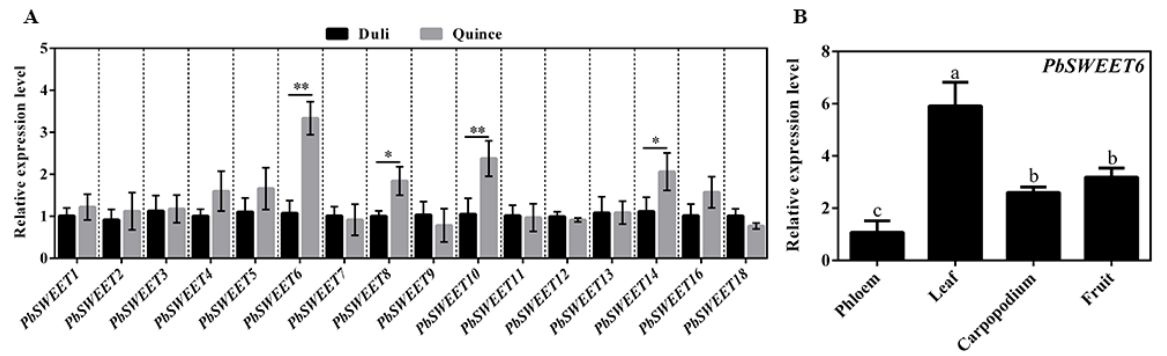
Figure 3. Selected and tissue-specific expression analysis of PbSWEET6 . ( A ) Relative expression of PbSWEET genes from mature fruits of ‘Zaosu’ pear grafted on ‘Yunnan’ quince (Z/Q) and ‘Duli’ (Z/D) as determined by qRT-PCR. ( B ) The relative expression levels of PbSWEET6 were detected in the phloem, leaves, carpopodium, and fruits of Z/Q during the mature fruit period. The data represent the mean values ± SDs. Different letters represent significant differences (Tukey’s HSD, p < 0.05) and asterisks indicate significant differences as determined by Student’s t tests (* p < 0.05, ** p < 0.01).